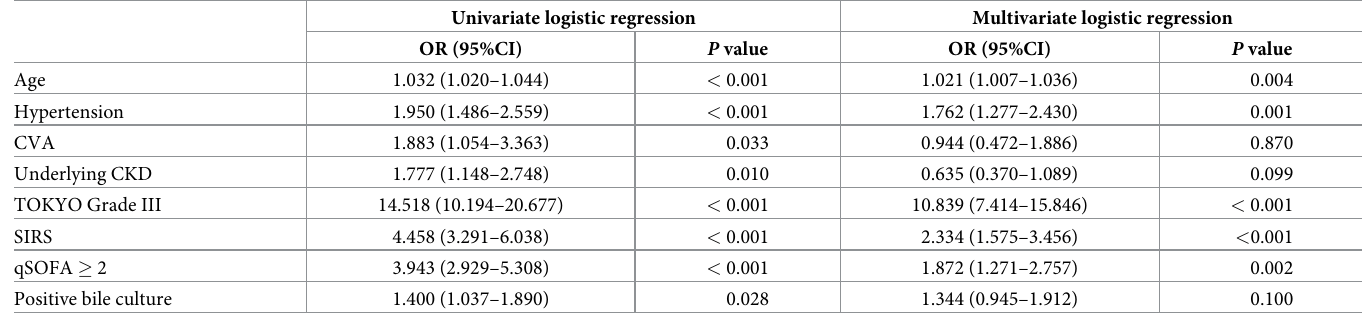
Table 2. Independent risk factors for the development of AKI.